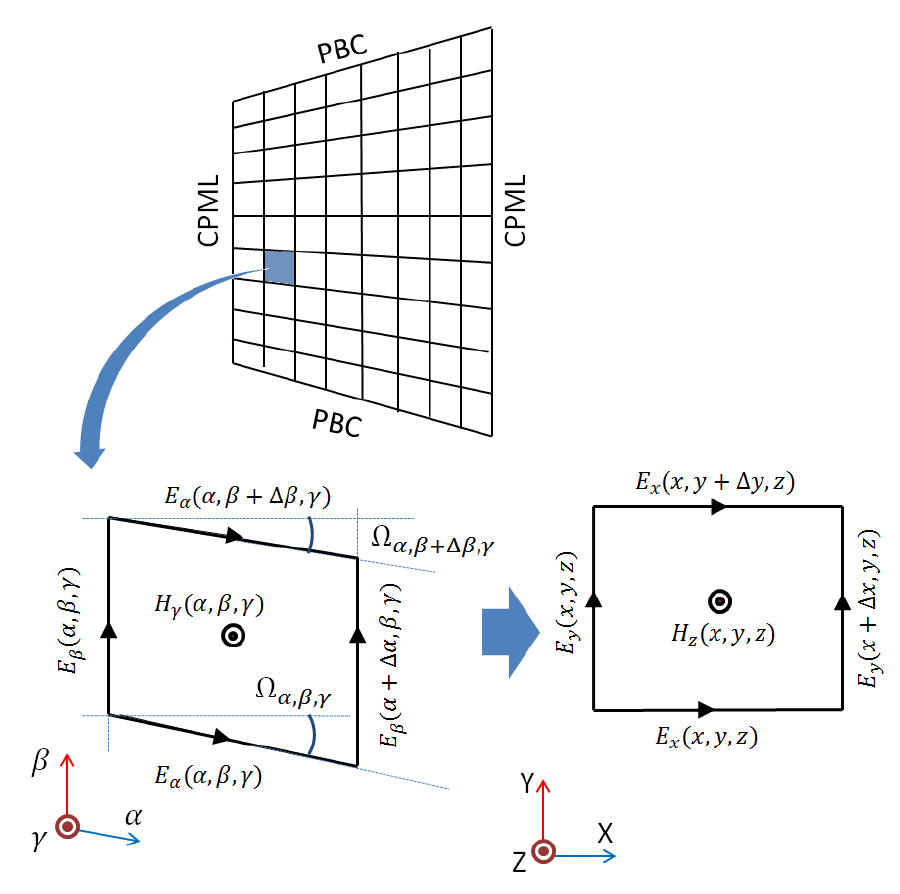
Figure 5. Illustration of the process of transforming the electric field component in the nonorthogonal grid into the electric field in the orthogonal